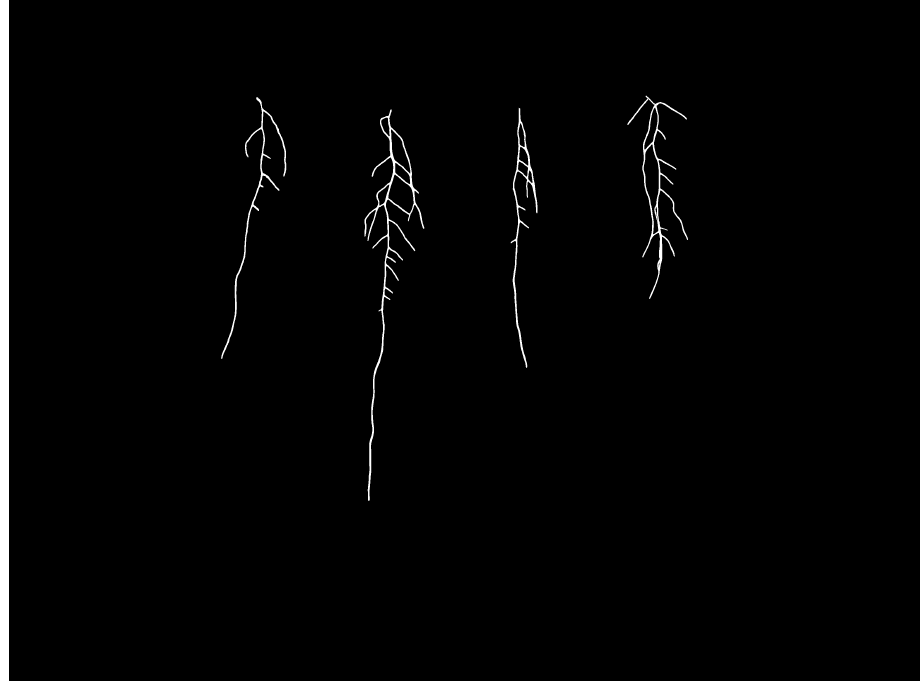
Figure 2. Example of the annotation corresponding to Figure